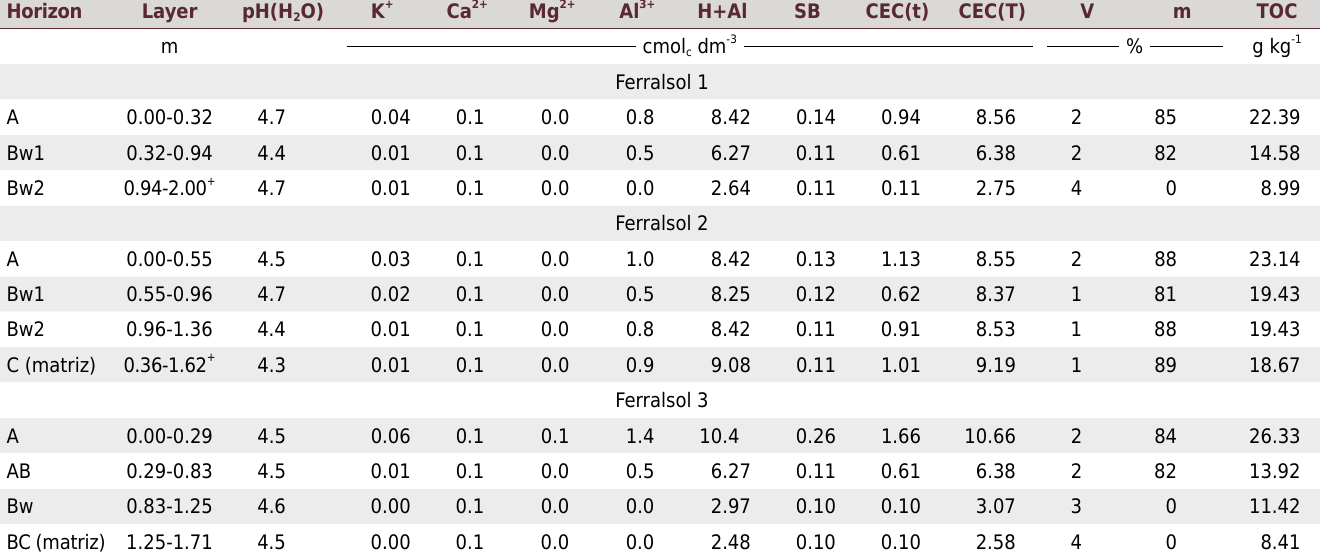
Table 3. Chemical properties of the three studied profiles (Ferralsols 1, 2 and 3)